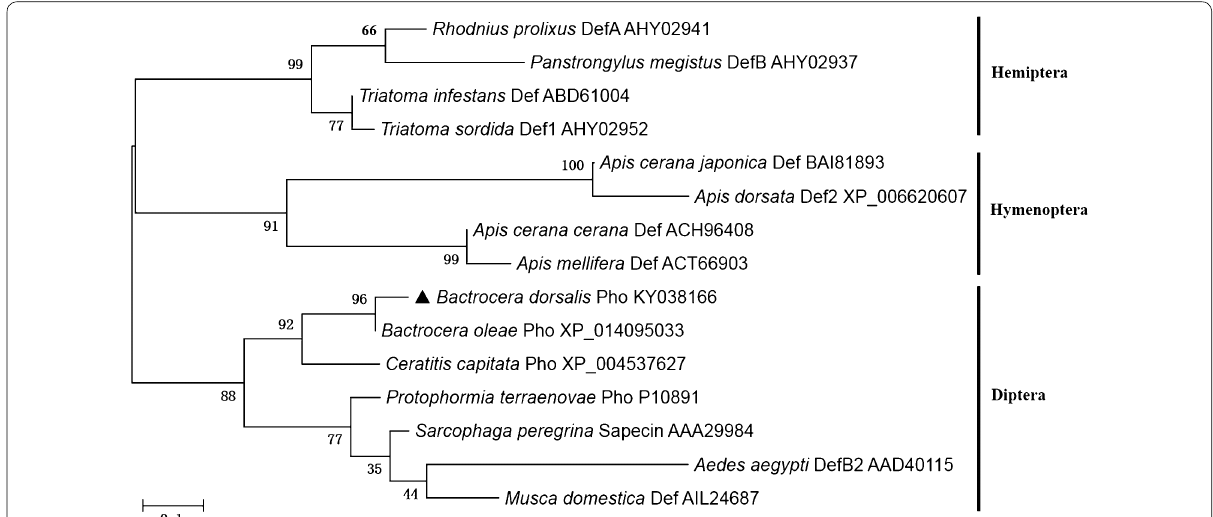
Fig. 3 Phylogenetic analysis of 15 insect phormicins and defensins. The phylogram of 15 insect defensin amino acid sequences was generated in MEGA 6.0 using Maximum Likelihood method. Scale bar